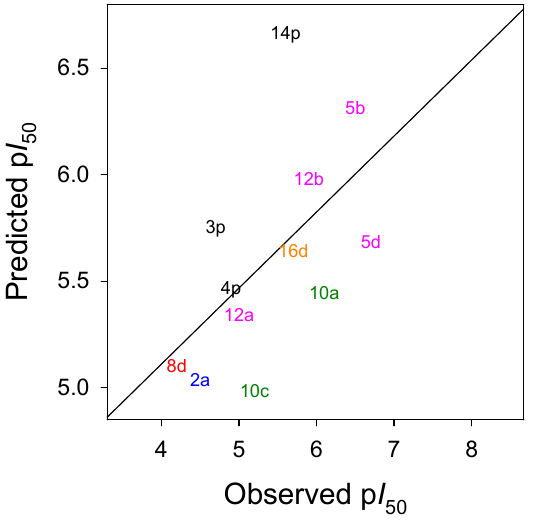
Figure 5. Model predicting activity of the compounds not included in the training set by plotting the relationship between observed and predicted values from the cross-validated leave-one-out partial-least-squares (PLS) analysis. Colors correspond to those used in Tables 1–4. R 2 = 0.96.